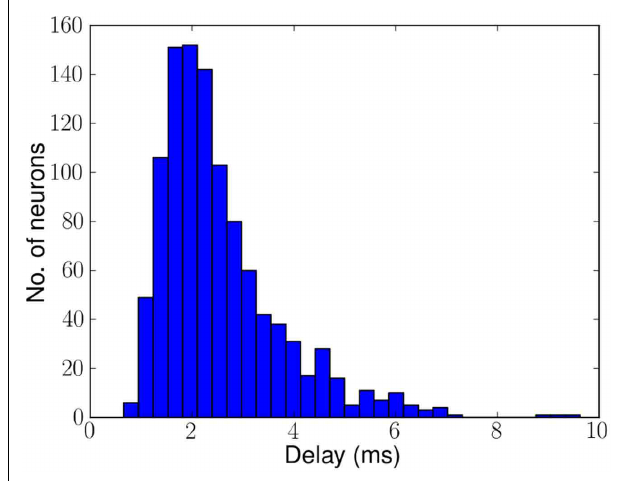
FIGURE 3 | Histogram of delays of 1070 of the 2048 neurons on CHIP–3 due to mismatch in the hardware. Delays range from 0.7 to 8.6ms mean ≈ 2.5ms.The remaining neurons either fire more than once or not at